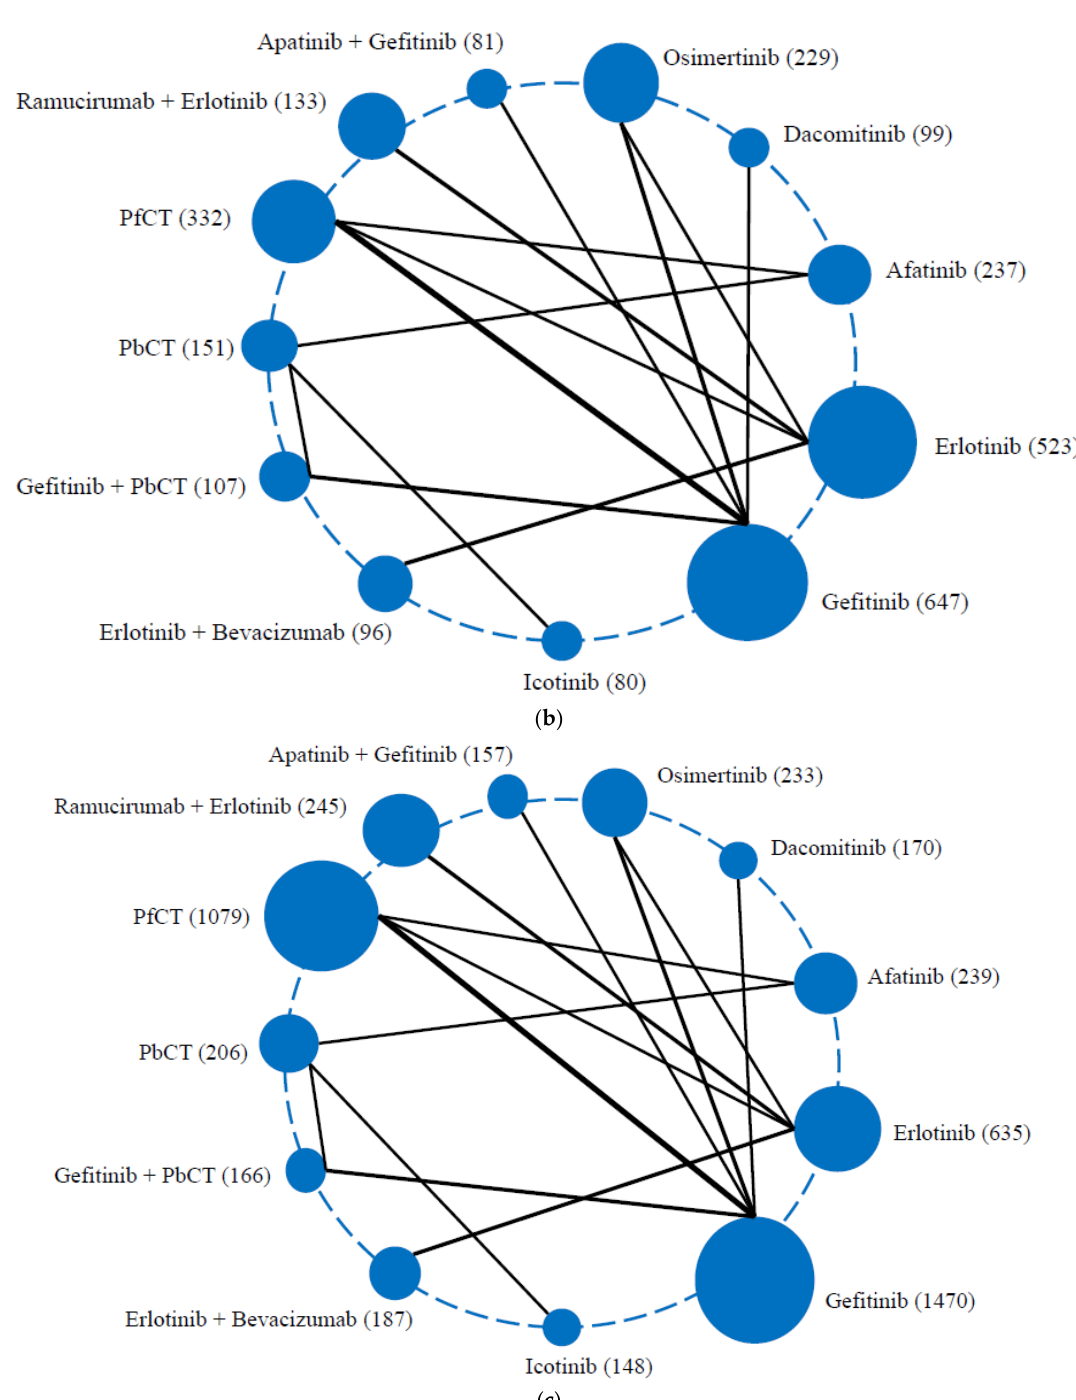
Figure 2. Schematic representation of the network of evidence in this network meta-analysis of first- line treatments in Asian patients with EGFR-mutated NSCLC harboring 19del. ( a ) Overall survival (gefitinib plus apatinib and ramucirumab plus erlotinib were not in this network as the corresponding overall survival data were not reported in trials). ( b ) Progression-free survival. ( c ) Toxicity in terms of grade ≥ 3 adverse events. The network is composed of nodes (treatments) connected by lines (head-to-head comparisons). The size of nodes is proportional to the number of patients in each first- line treatment (in brackets). The width of lines is proportional to the number of comparisons. 19del, exon 19 deletion; EGFR-mutated, epidermal growth factor receptor-mutated; NSCLC, non-small cell lung cancer; PbCT, pemetrexed-based chemotherapy; PfCT, pemetrexed-free